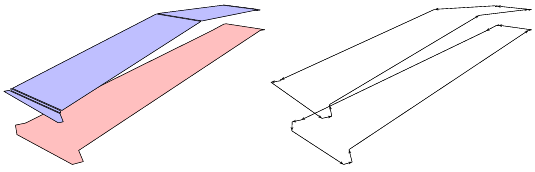
Figure 4. The output of this step should be a pair of paths that meat the defined criteria. In this figure, the roof of two different LoDs of the same building is shown as 2-cells (faces) on the left and the output of this step is shown as a path of darts on the right. Notice how the darts that may belong to different faces of the original objects, meaning that the traversal did not follow only the β 1